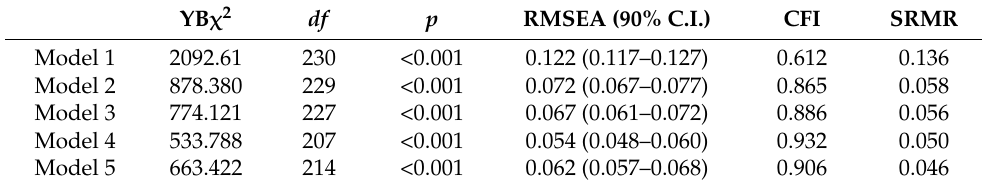
Table 2. Fit Indexes of the measurement